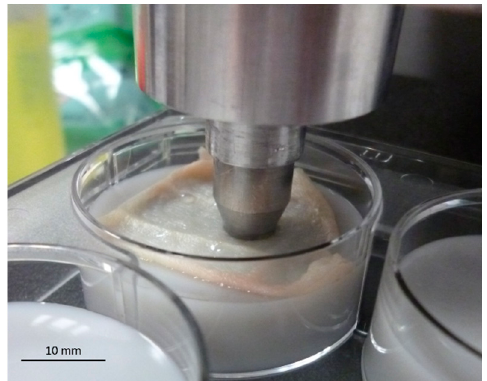
Figure 6. Optical probe of the SpectroLive device put in contact with an ex vivo human skin sam ‐ ple on top of a fluorescent gel made of agarose and AgUIX® nanoparticles (NH TherAguix®, sample on top of a fluorescent gel made of agarose and AgUIX®nanoparticles (NH TherAguix®, Meylan, France). Meylan,